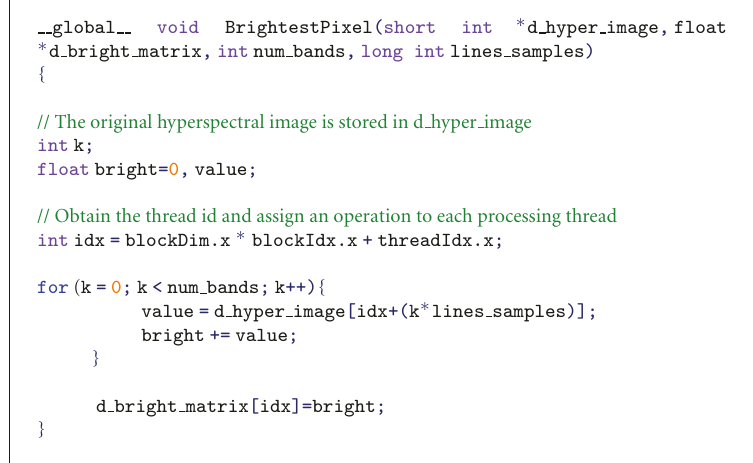
Figure 9: CUDA kernel BrightestPixel that computes (in parallel) the brightest pixel in the scene in the G-ATDCA implementation.